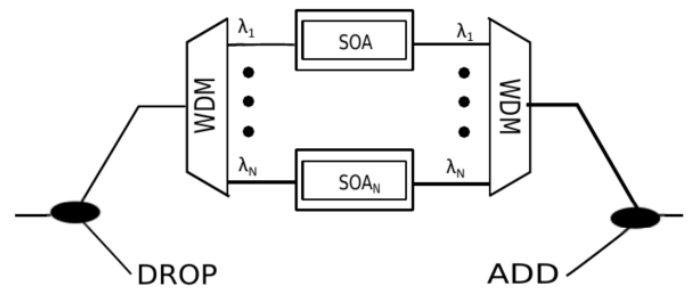
Figure 2. Architecture of a SOA-based OAD node.